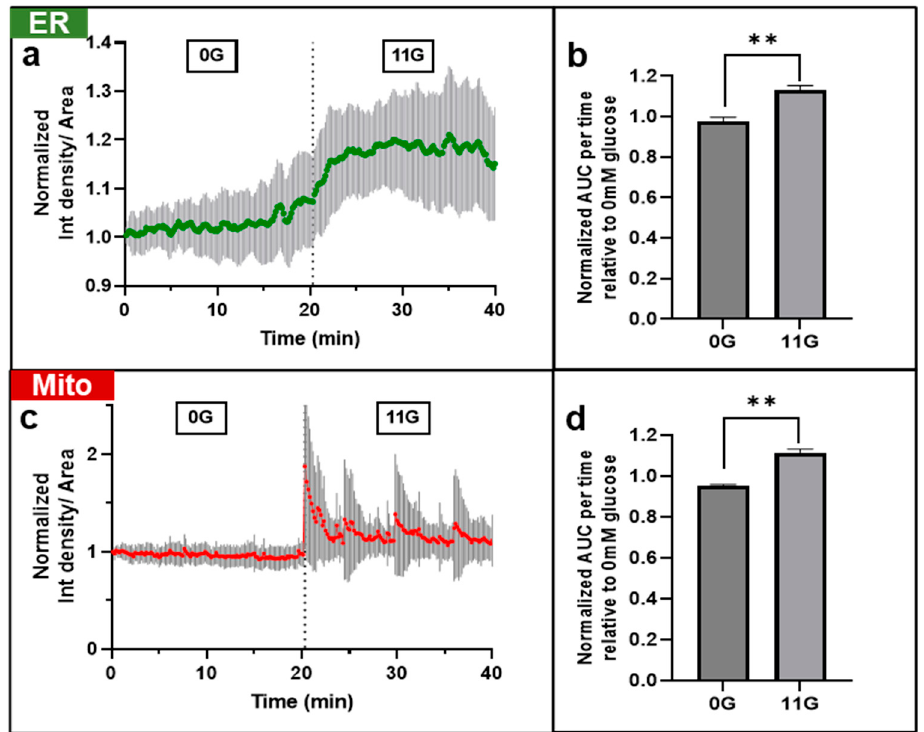
Figure 3. Characterization of the glucose responses in INS1-832/13 cells expressing DS-1. ( a , c ) Mean fluorescent traces of ER and mito with standard deviation in gray lines. ( b , d ) Quantitation of response illustrated as normalized AUC (area under curve) relative to 0 mM glucose (initial perifusion solution). ** represents statistical significance p < 0.05. Representative ER and mito traces of individual cells are shown in Figure S6.